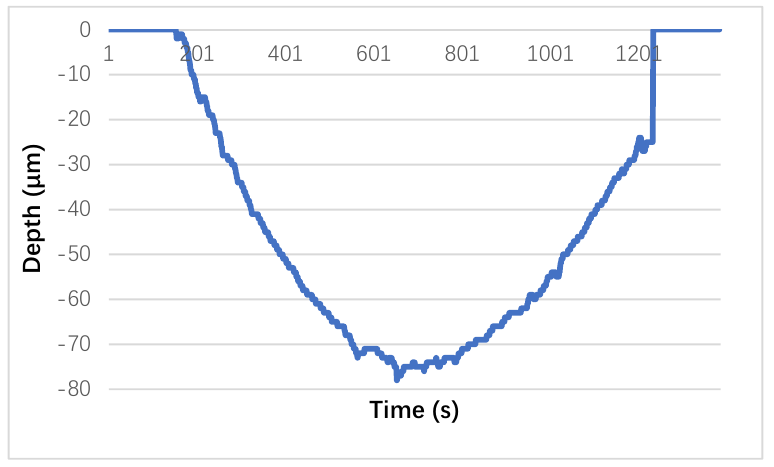
Figure 8. Average wear variation for the Extrudr BDP Flax material. Table 7. Wear depth values for Extrudr BDP Flax.